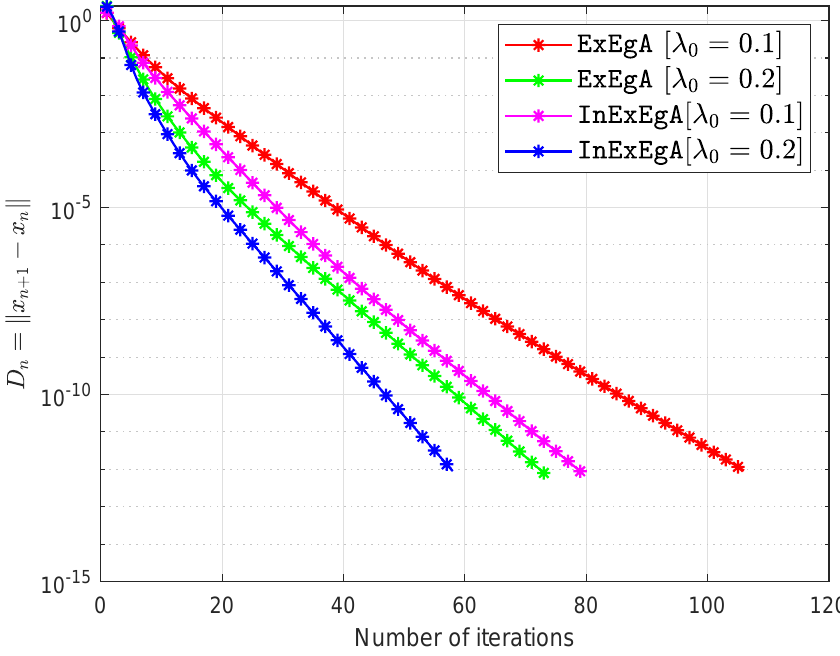
Figure 2. Algorithm 1 comparison with Algorithm 1 in [16] in term of iterations when n =